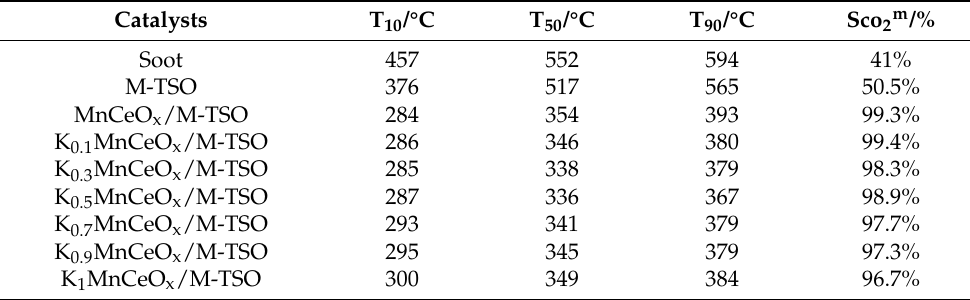
Table 3. Catalytic performance of prepared catalysts for soot combustion.